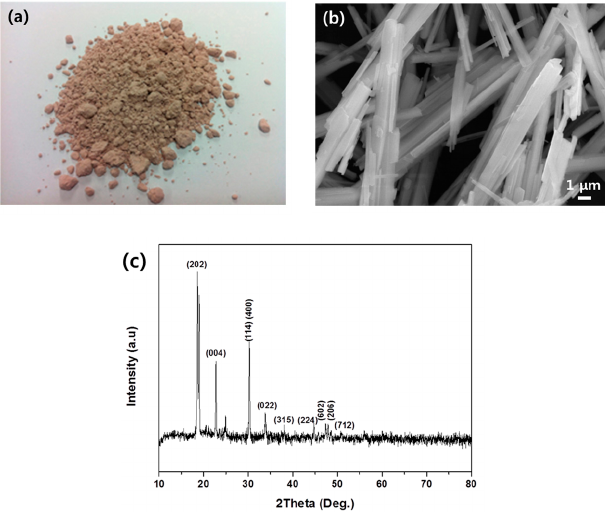
Figure 3. ( a ) Optical image; ( b ) SEM image of precipitated Co-oxalate; ( c ) powder XRD pattern.